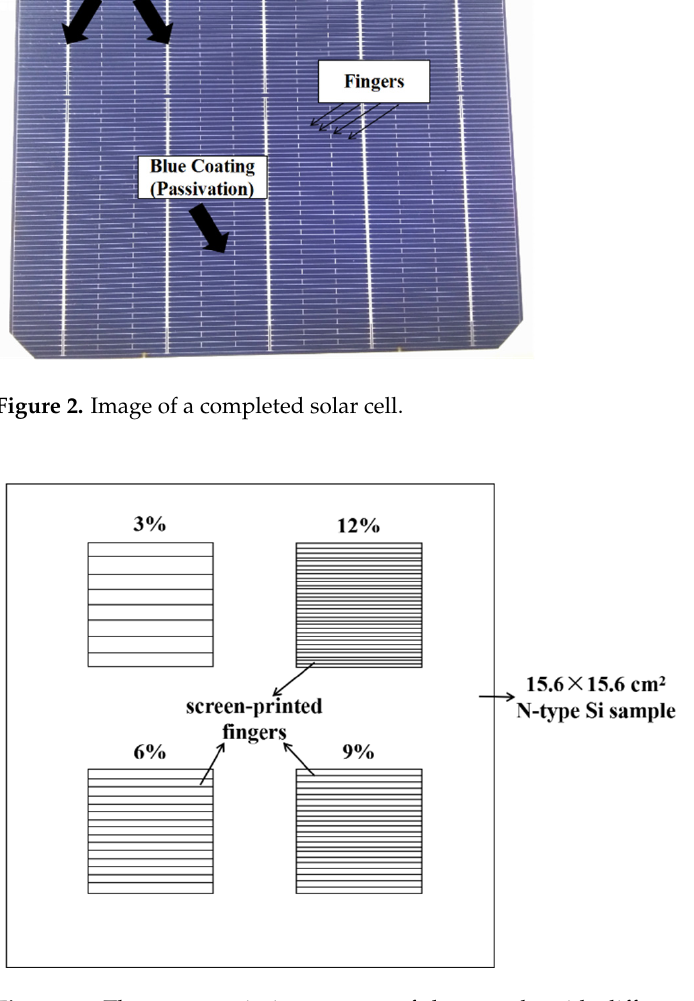
Figure 2. Image of a completed solar cell.